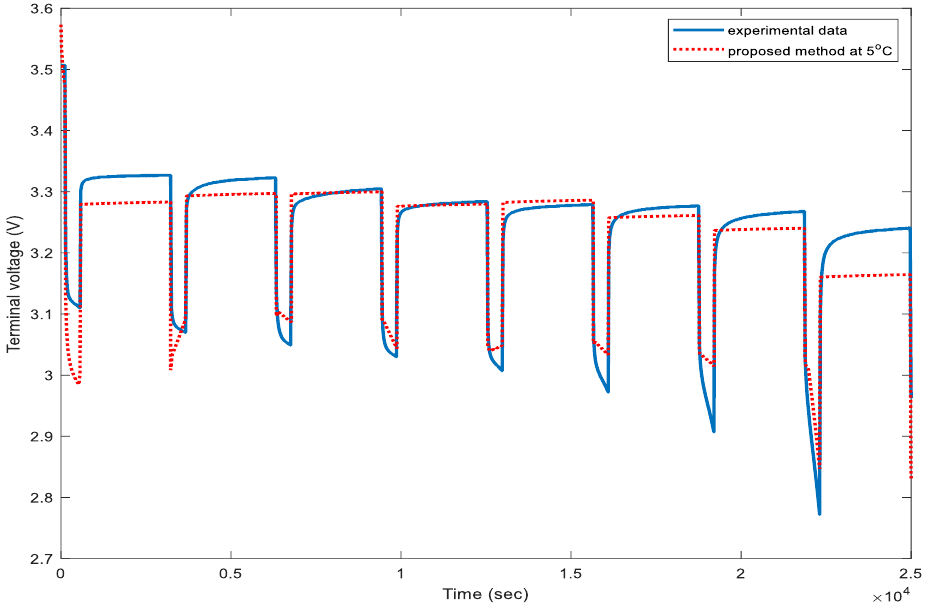
Figure 15. Terminal voltage at different ambient temperature of 5 °C.